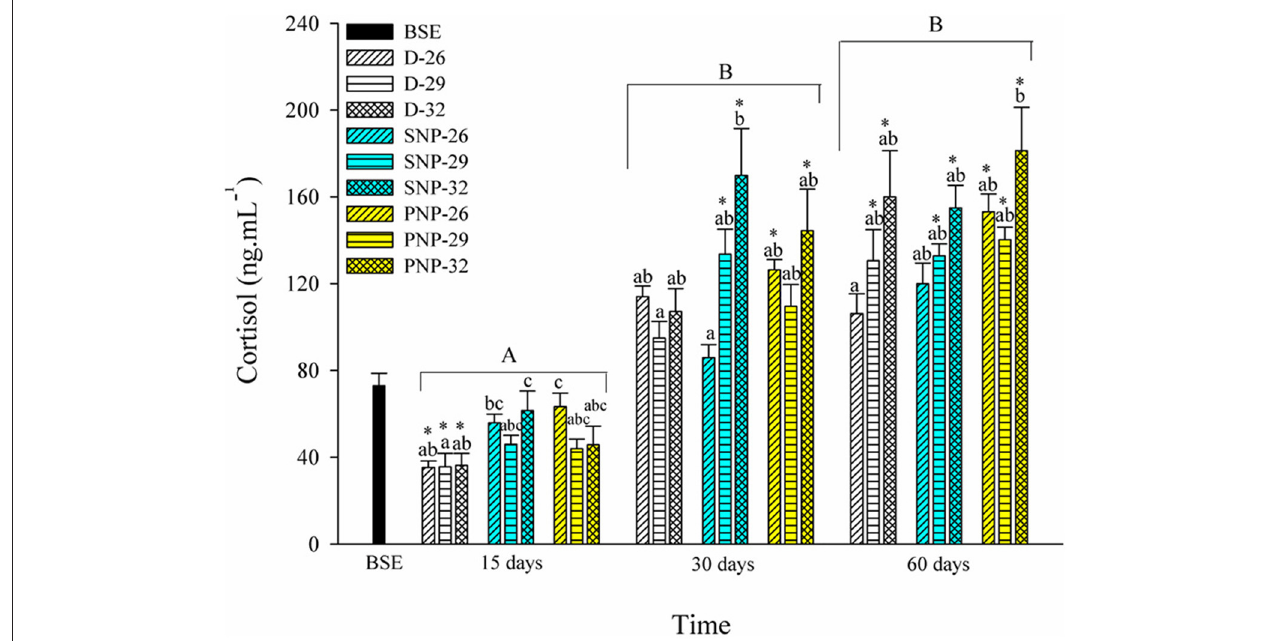
FIGURE 3 | Plasma cortisol of juveniles of Colossoma macropomum under controlled conditions of photoperiod and temperature. Data are expressed as mean ± SEM ( N = 3). Different lowercase letters indicate significant differences between treatments at the same experimental period ( p < 0.05). The horizontal lines on the bars represent differences in experimental periods ( p < 0.05). * Indicate differences of the treatments in relation to BSE group.